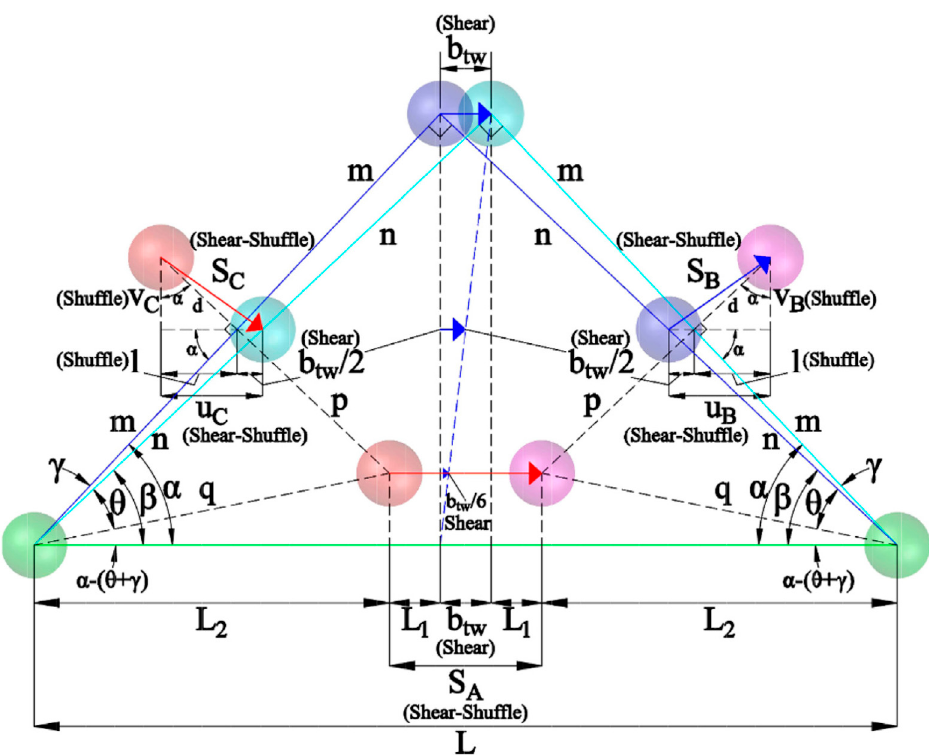
Figure 1. The schematics of the transformation of the untwinned parent unit cell (blue segments and red and blue atoms) into the twinned children unit cell (cyan segments and magenta and cyan atoms for the first two layers close to the twin boundary) during (cid:4666)101(cid:3364)2(cid:4667)(cid:4670)1(cid:3364)011(cid:4671) twinning (After Namakian and Voyiadjis [40]).